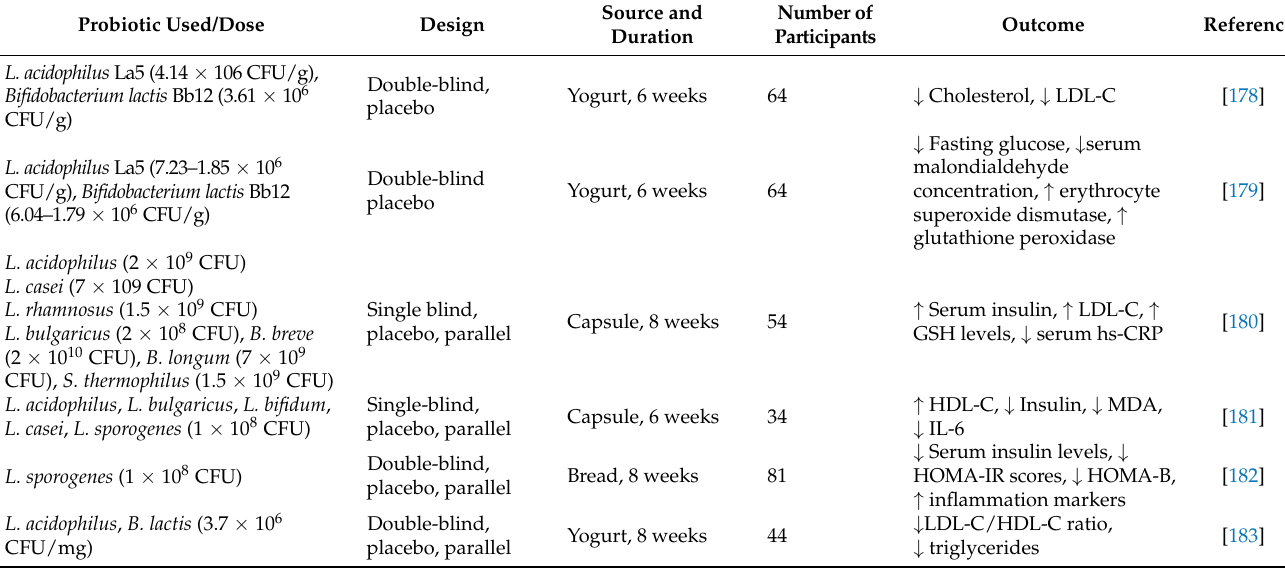
Table 3. The role of various probiotics and their metabolic outcomes related to